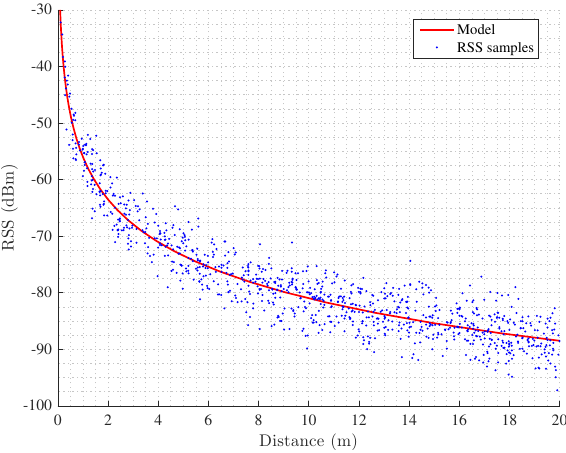
Figure 4. Calibration of a propagation